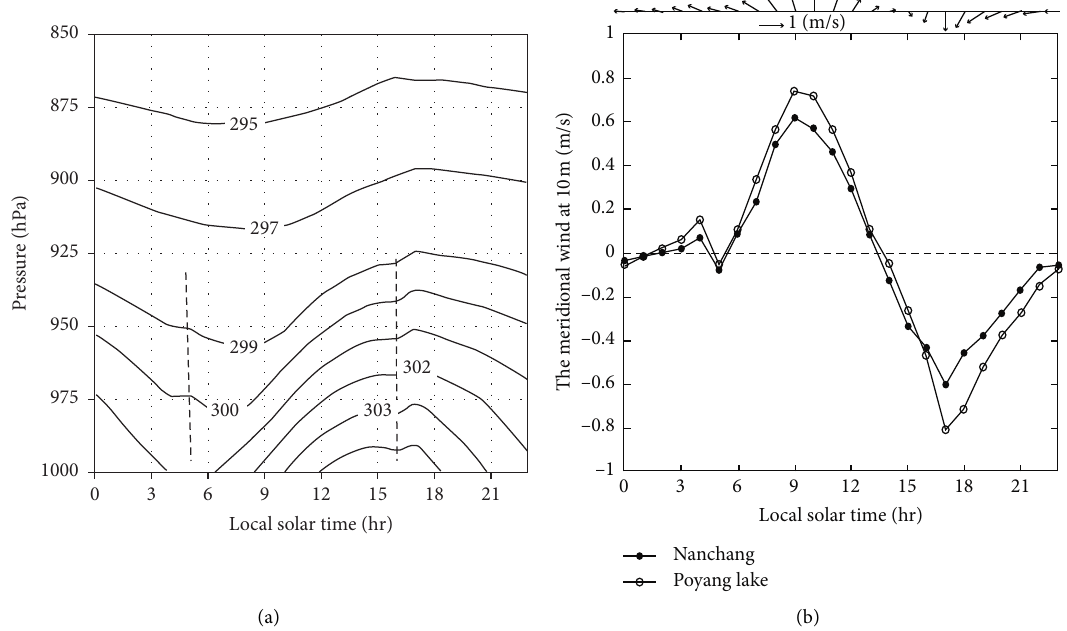
Figure 8: (a) The diurnal variations of air temperature (K) below 850hPa over PL and (b) the diurnal variations of 10 m meridional wind (m s − 1 ) over PL and Nanchang and the 10 m wind (arrows, unit: m s − 1 ) over PL. It is noted that the grids of 116.25 ° E, 29 ° N and 116 ° E, 28.5 ° N represent PL and Nanchang in ERA5 reanalysis data, respectively.